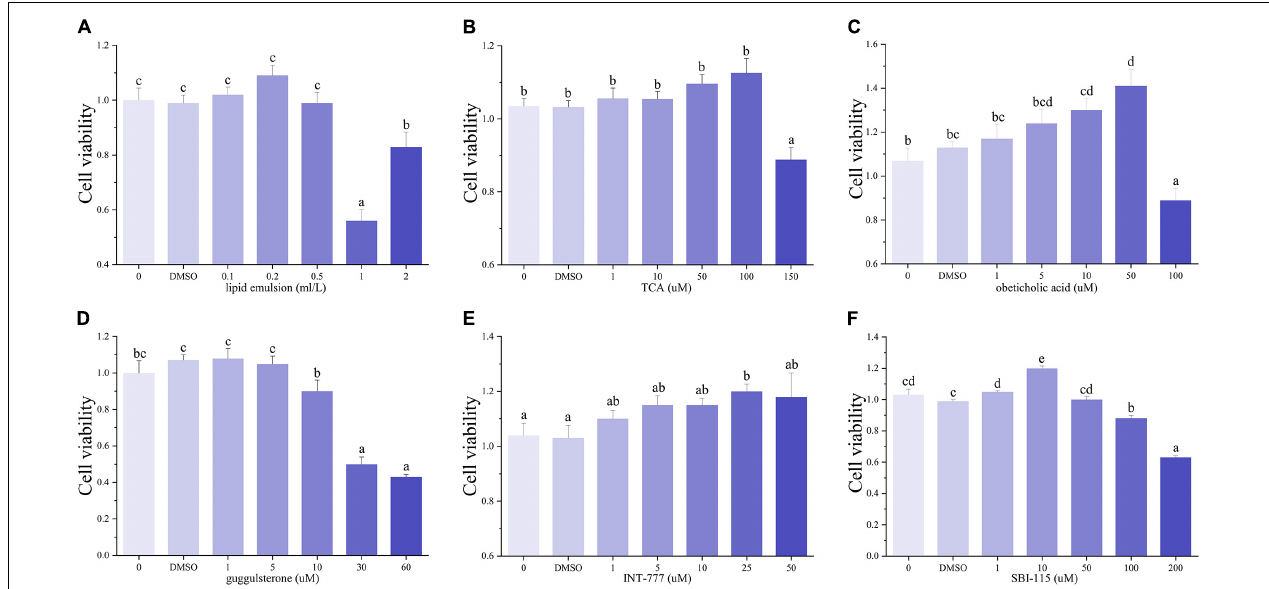
FIGURE 1 | The cell viability of hepatocytes incubated with lipid emulsion (A) , TCA (B) , obeticholic acid (C) , guggulsterone (D) , SBI-115 (E) , and INT-777 (F) at different concentrations ( n = 9). TCA: taurocholic acid sodium; obeticholic acid: INT-747, FXR agonist; guggulsterone: FXR antagonist; SBI-115: TGR5 antagonist; INT-777: TGR5 agonist. Values are presented as means with standard deviation, where significant ( p < 0.05) differences between groups are indicated by different letters (a–e).